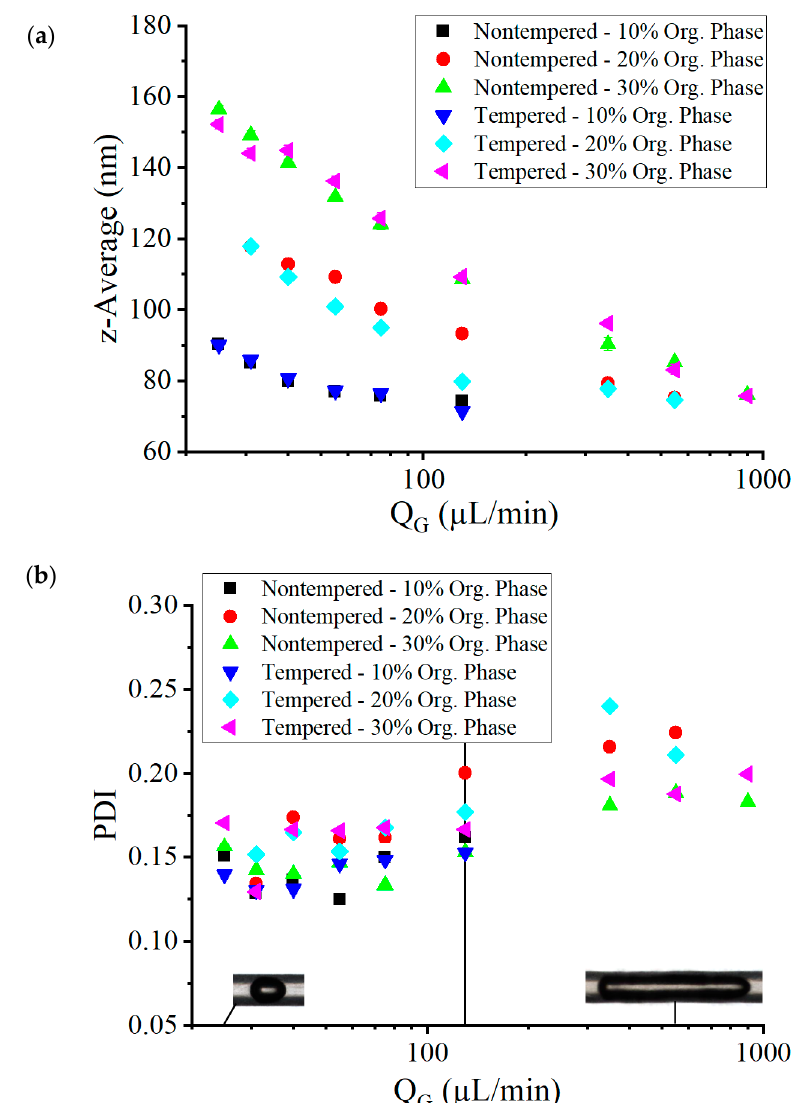
Figure 9. The average size ( a ) of lipid nanoparticles and their polydispersity index (PDI) ( b ) depending on the gas volume flow rate in the nontempered and tempered system at a total liquid volume flow rate of 200 µ L/min and different concentrations of the organic phase. The vertical line at Q G = 130 µ L/min marks the point of lowest difference between l P and l P , Calc at l B ≈ 2 d Ch as indicated in Figure 8b.